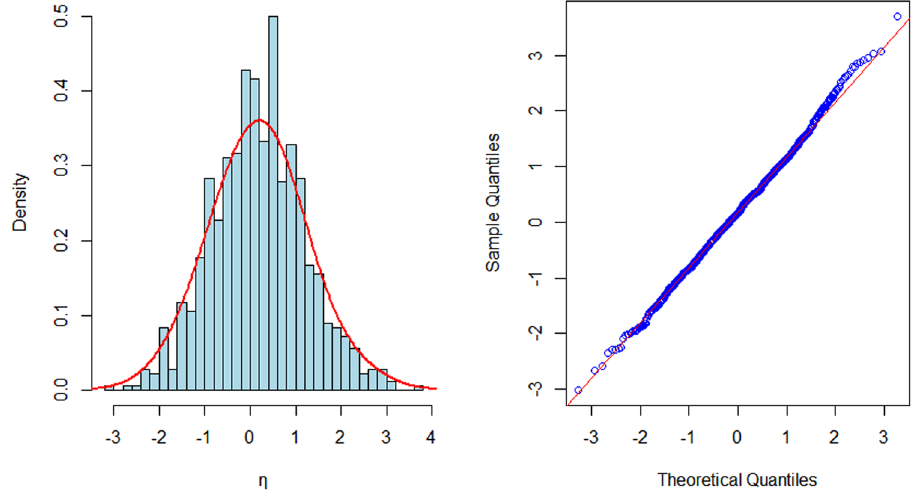
Figure 4: Histogram and normal Q – Q plot of